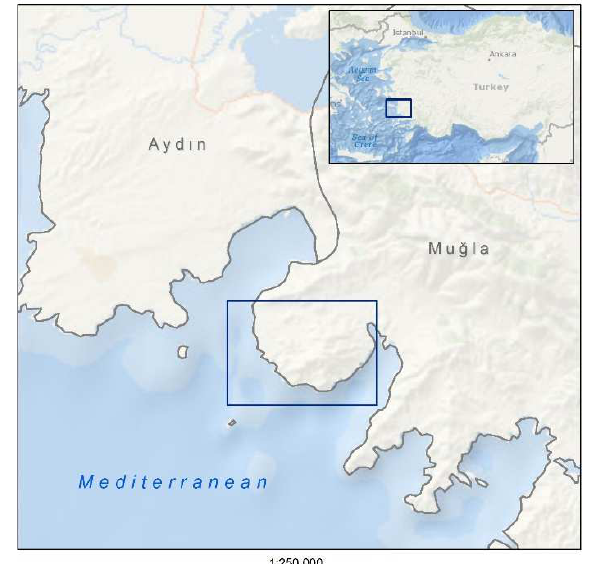
Figure 3. General workflow of the study